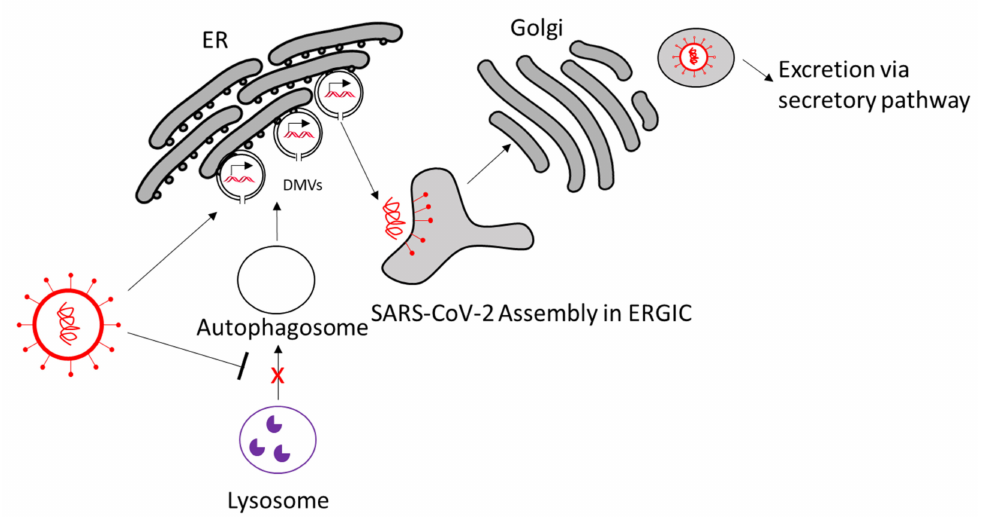
Figure 4. SARS-CoV-2 uses double-membrane vesicles and the autophagosomal pathway for replica- tion. SARS-CoV-2 inhibits the fusion of lysosomes with autophagosomes. SARS-CoV-2 uses DMVs originated from the ER as replication sites and uses parts of the autophagosomal pathway for replica- tion. Viral particles are assembled in the ERGIC and are excreted via the secretory pathway. ER, endo- plasmic reticulum; DMV, double-membrane vesicle; ERGIC, ER–Golgi intermediate compartment. Accumulation of nonlytic autophagosomes can be beneficial for SARS-CoV-2 by using them as autophagosome-like double-membrane vesicles (DMVs). Indeed, these DMVs are induced in SARS-CoV-2-infected cells, described as inhabiting double-stranded RNA,